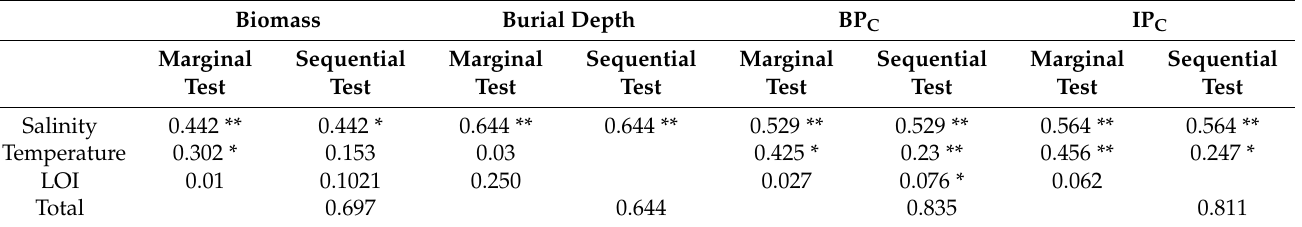
Table 4. Proportion of the variables explaining the distLM model adjustment in marginal and sequential tests for biomass, burial depth, BP C and IP C . Burial Depth BP C IP